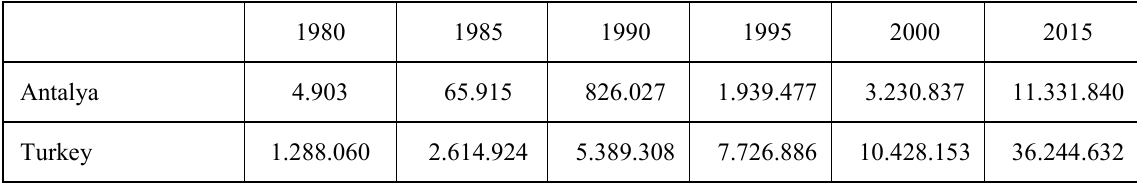
Table 1. Number of tourists coming to Turkey and Antalya by years 1980 1985